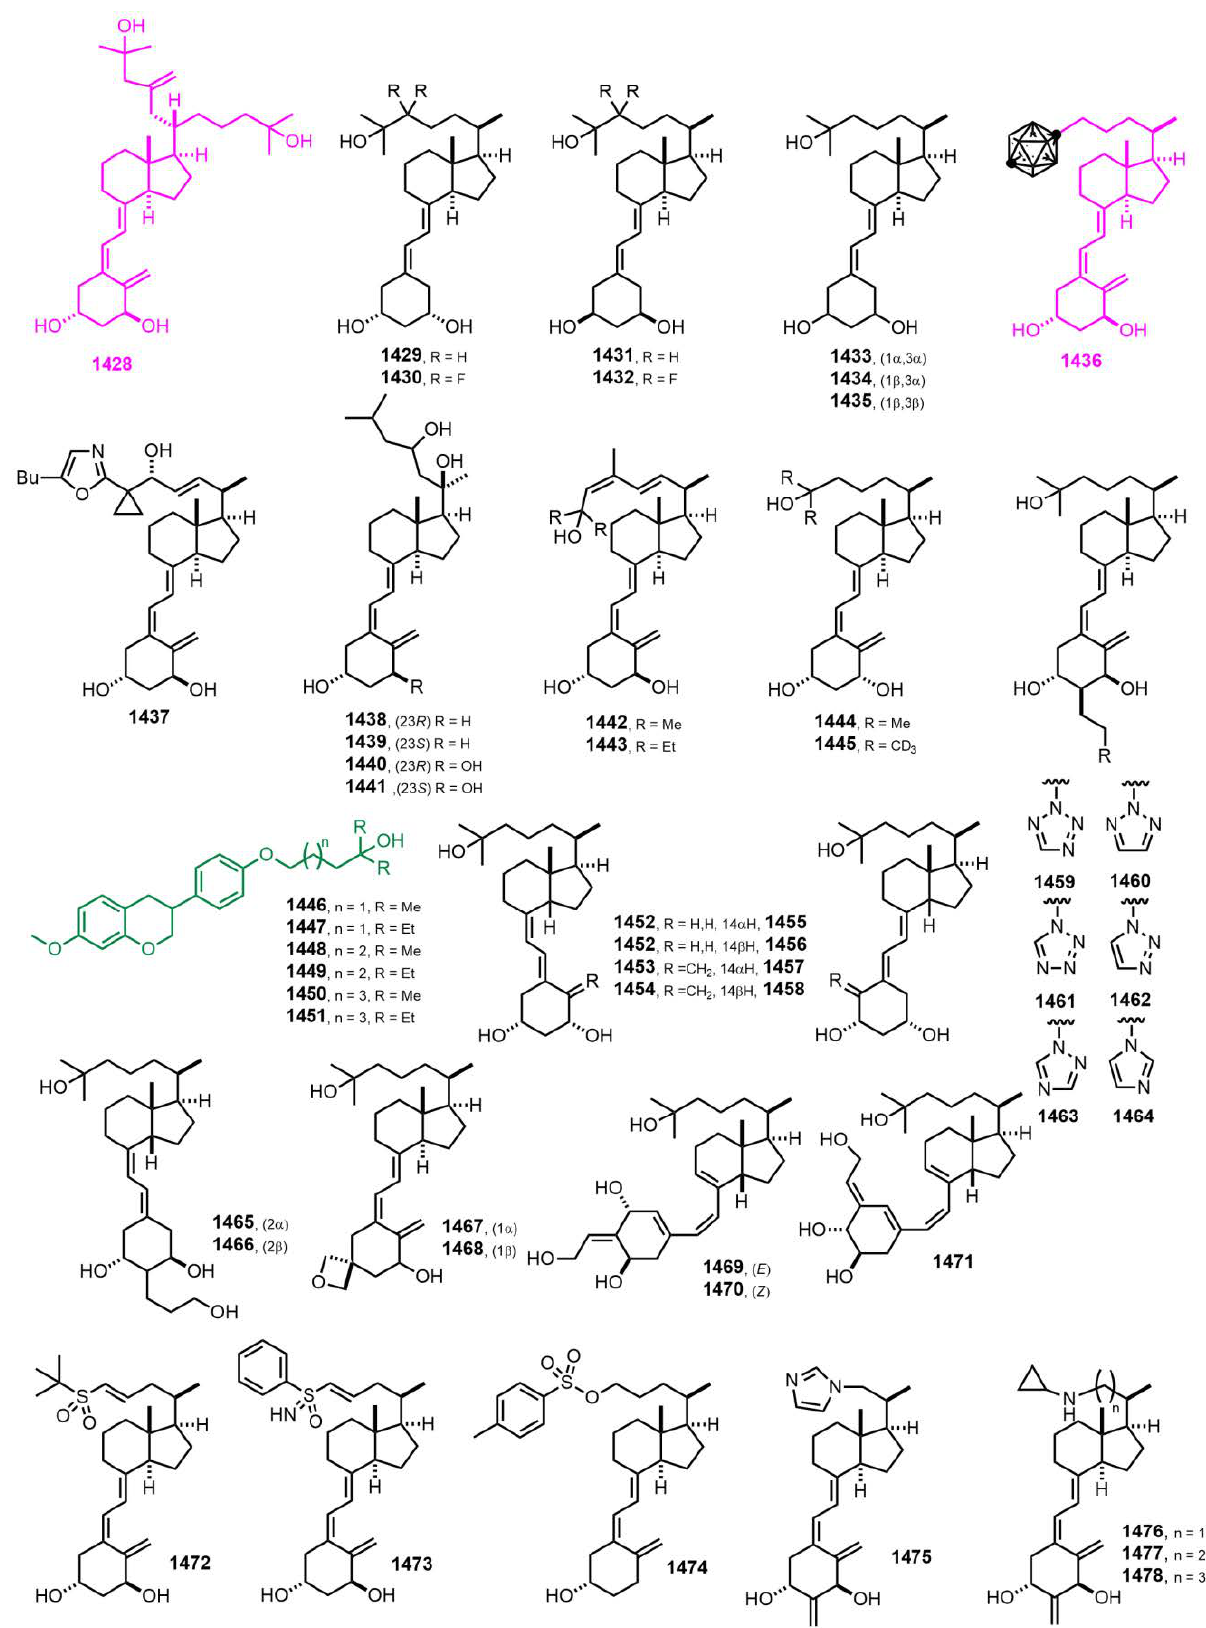
Figure 25. (2015–2017)